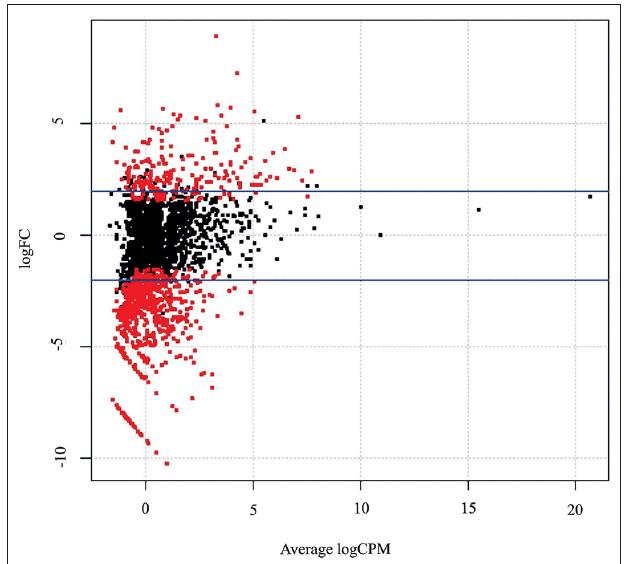
FIGURE 4 | Differentially expressed genes in M. glaucescens explants before (control) or after (treated) shoot organogenesis induction. Blue lines indicate genes with no significant changes in expression (1,241 genes); whereas red dots indicate genes that were either significantly downregulated (226) or upregulated (591) in treated explants. The false discovery rate was set at P ≤ 0.05. FC, fold change; CPM, counts per million mapped